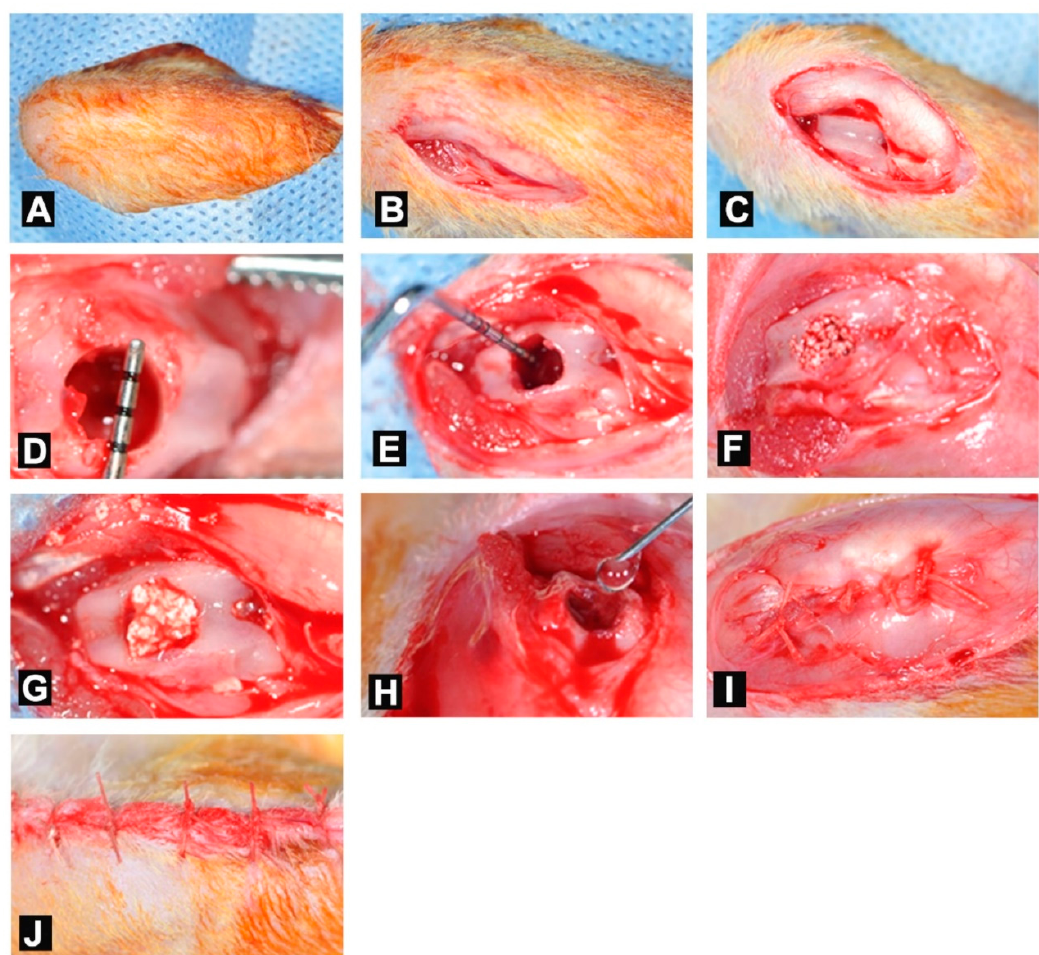
Figure 1. Representative surgical images of bone defect preparation and bone-grafting procedures. ( A ) Surgical site preparation of the skin over the femoral condyle; ( B ) parapatellar incision over the knee joint capsule; ( C ) soft tissue reflection to expose the underlying femoral condyle; ( D , E ) experimental bone defect measuring 3 mm in diameter and 3 mm in depth; ( F – H ) bone defects filled according to the experimental grouping protocol; ( I ) closure of subcutaneous tissues; and ( J ) skin closure.